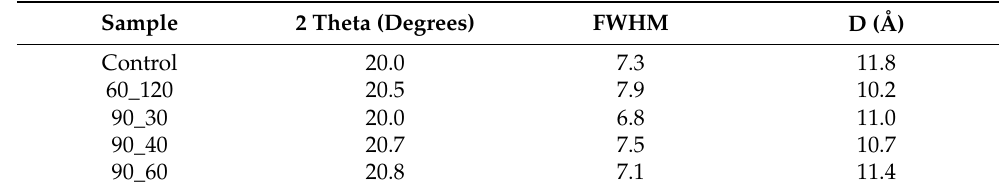
Table 2. FWHM and crystallite size of PBSeT at main crystalline peak. The code for each sample is specified as SSP temperature_SSP processing time (e.g., 90_40 corresponds to the sample subjected to the SSP process at 90 ◦ C for 40